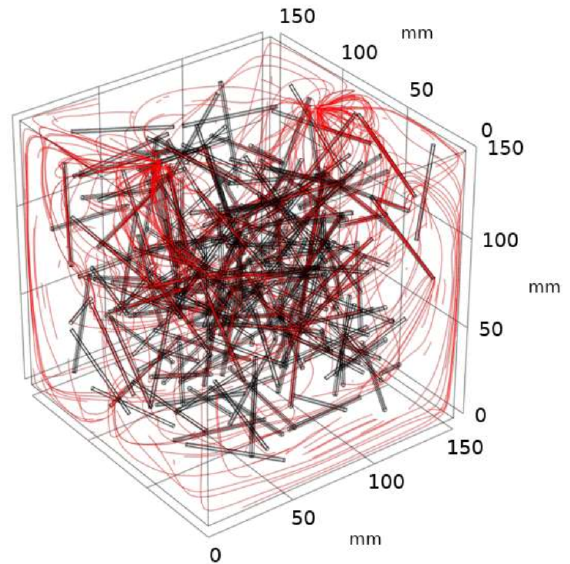
Figure 6. Electrical conductivity lines in the simulated